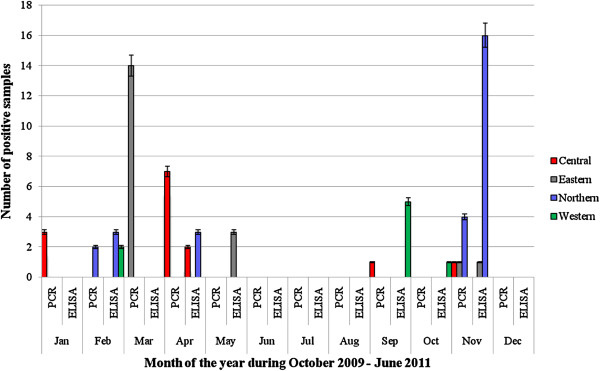
Temporal distribution of RT-PCR and ELISA positive samples. Key: Fig = Figure; RT-PCR = Reverse transcriptase polymerase chain reaction; ELISA = Enzyme-linked immunosorbent assay; Jan = January; Feb = February, Mar = March; Apr = April; May = May; Jun = June; Jul = July; Aug = August; Sep = September; Oct = October; Nov = November; Dec = December.